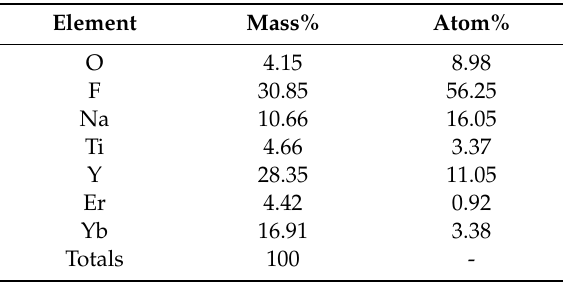
Table 2. Elemental analysis for TiO 2 / NaYF 4 :Yb,Er.